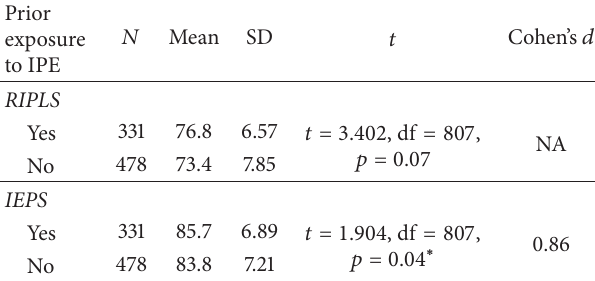
Table 5: Mean scores for RIPLS and IEPS by prior